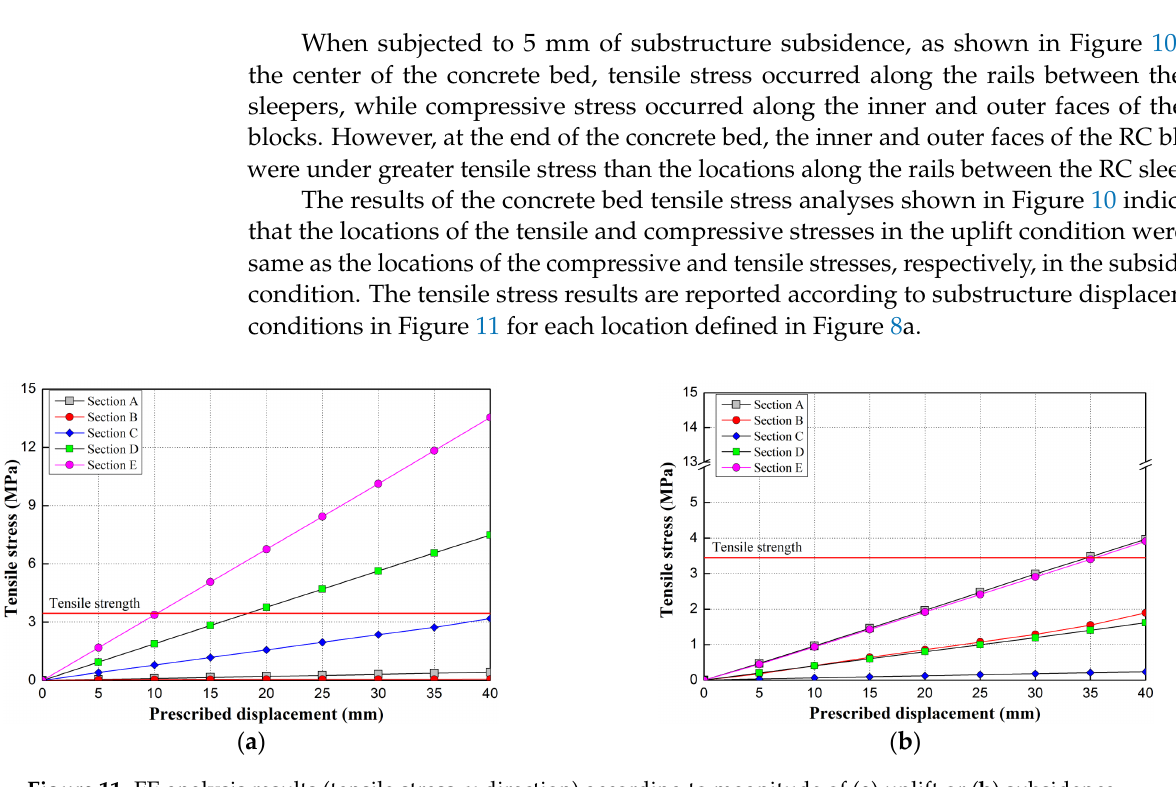
Figure 11. FE analysis results (tensile stress, x direction) according to magnitude of ( a ) uplift or ( b ) subsidence.